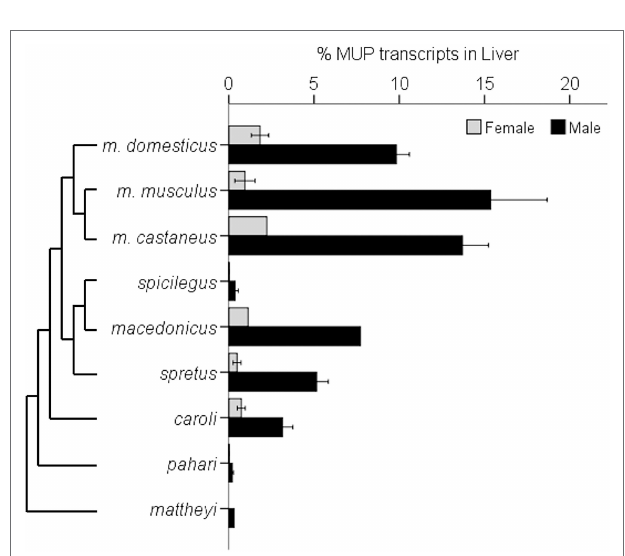
FIGURE 10 | Sexually Dimorphic MUP Gene Expression in Mus Species. The graph illustrates sexually dimorphic expression of MUP genes in relation to a Mus species from Steppan and Schenk (2017) and M. musculus subspecific phylogeny from Macholán et al. (2012). Sex differences in MUP expression among Mus species and subspecies [mean percentages of total MUP gene expression in liver tissue composed of Mup3, Mup20 , and central MUPs; data from Sheehan et al. (2019)]. Error bars are ±1 SEM ( N = 1 where error bars are absent). Mup20 is strongly male-biased in M. musculus , but it is not found in most other species, and although Mup3 was thought to be male-specific, it is expressed in female M. m. domesticus and some other species. Data from Sheehan et al.,